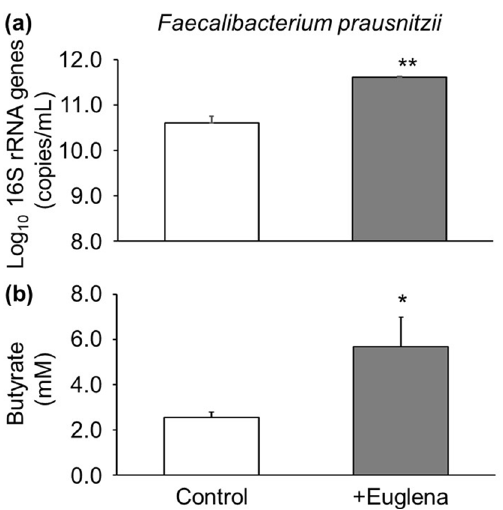
Figure 3. ( a ) Cells detected by real-time PCR and ( b ) concentration of butyrate produced by Faecalibacterium prausnitzii without Euglena gracilis (Control) and with E. gracilis addition (+ Euglena) after 72 h of cultivation. * P < 0.05, ** P < 0.01, n = 3, two-tailed Student’s t